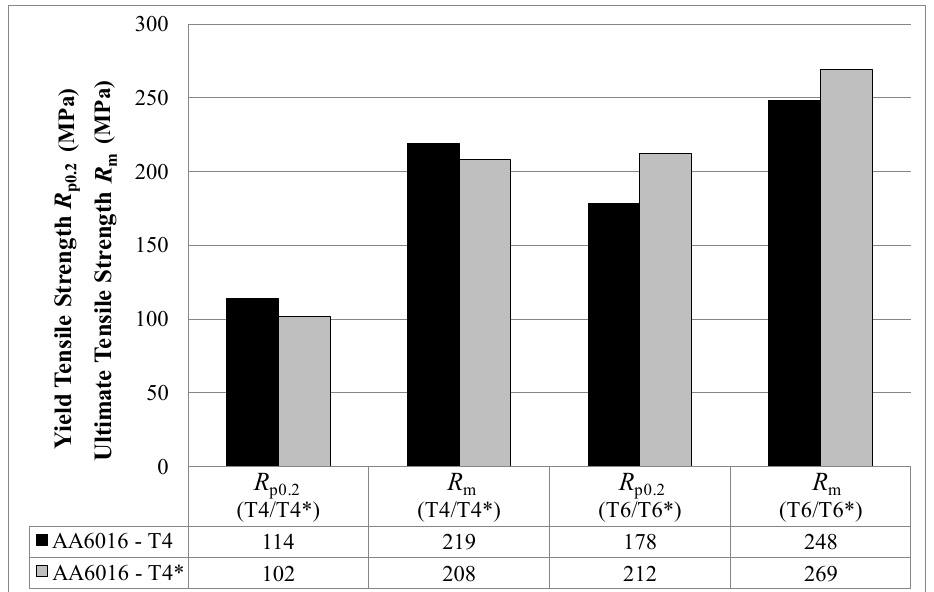
Figure 7. Yield tensile strength R T6 and T6* measured one month after sheet production (LT-direction).